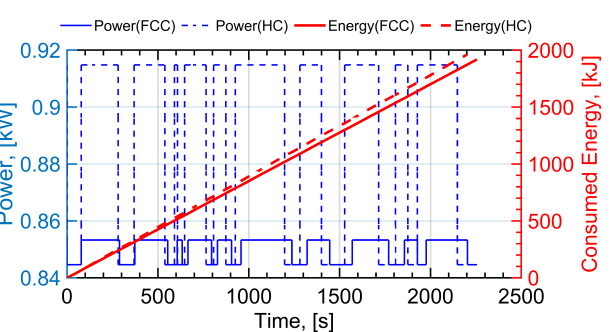
Figure 10. The variation in propulsion power and energy for 10 IoT users is plotted when the altitude of UAV is 200. The serrated blue curves denote the propulsion power. The red dotted line represents the variation in UAV energy consumption with time under HC design. The red solid line denotes the variation in UAV energy consumption with time under the proposed FCC